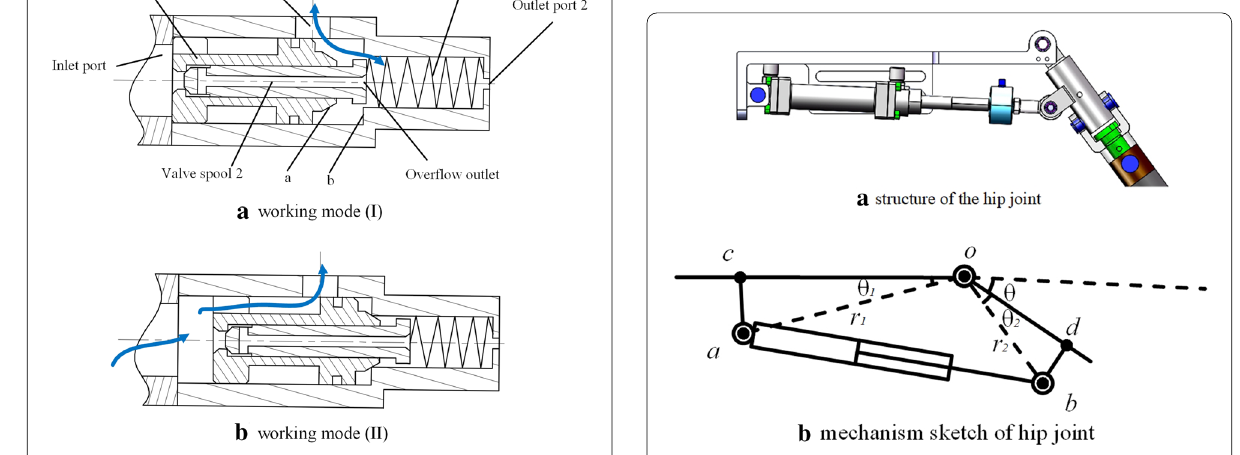
Figure 6 Structure diagram of the compact valve Figure 7 The hip joint driven by